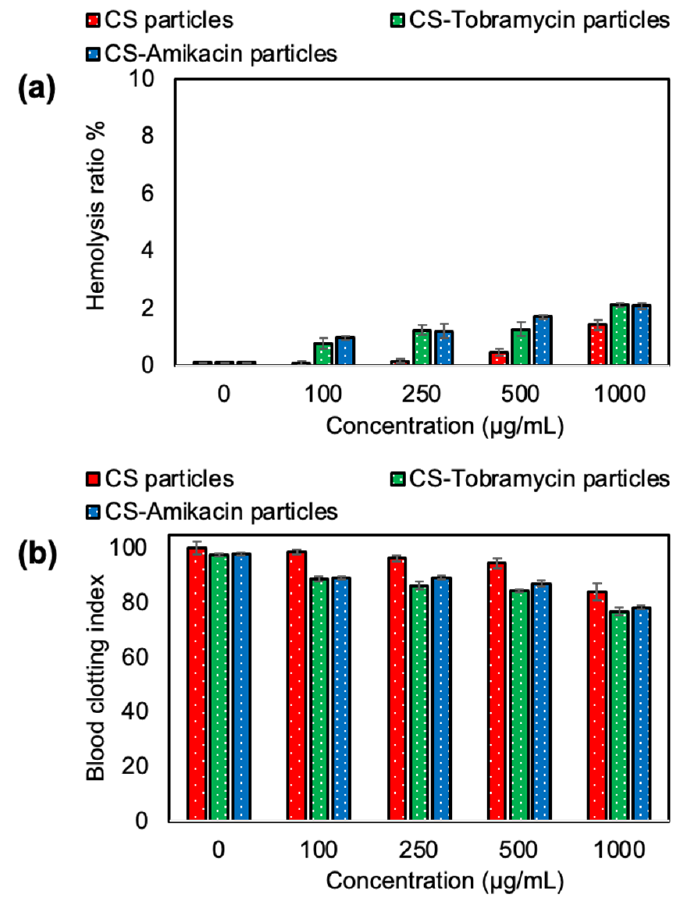
Figure 5. ( a ) Hemolysis and ( b ) blood clotting index of CS particles, CS-Tobramycin particles and CS-Amikacin particles crosslinked at 50% mole ratios.